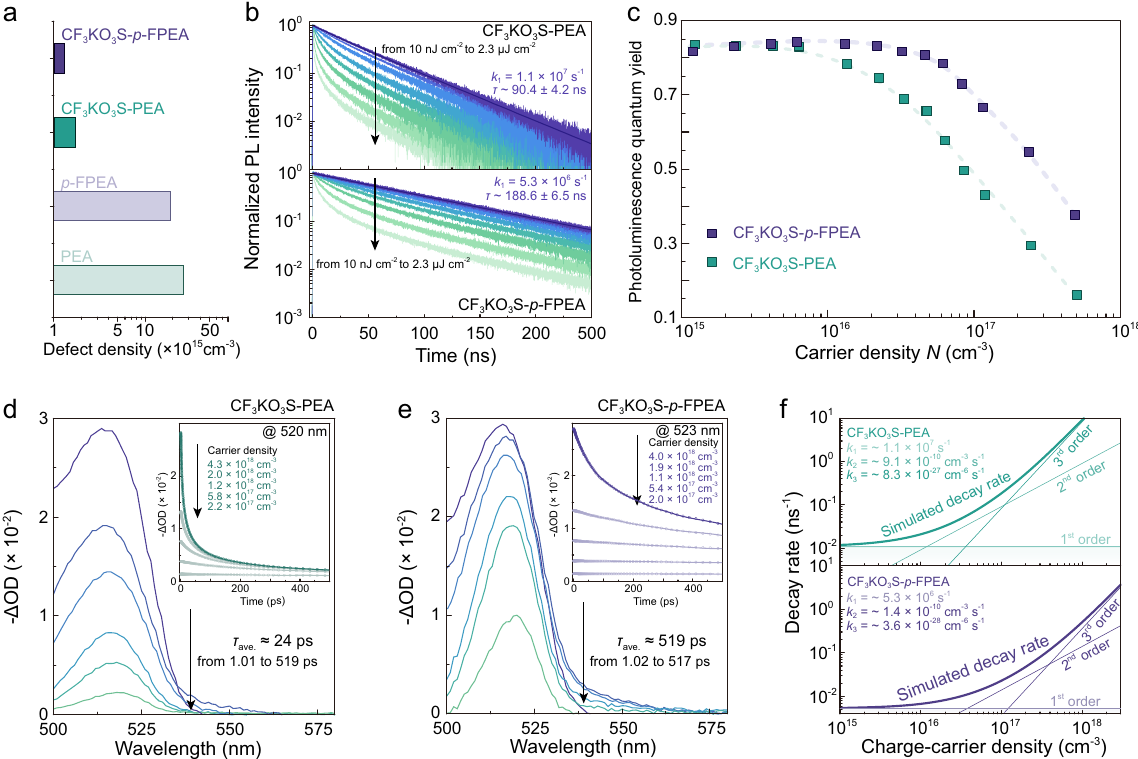
Fig. 3 Recombination dynamics for CF 3 KO 3 S treated quasi-2D fi lms. a Extracted defects density for different perovskite fi lms according to SCLC measurements. b TRPL spectra for CF 3 KO 3 S-PEA and CF 3 KO 3 S- p -FPEA fi lms under different excitation. c Film ’ s PLQYs as a function of carrier density for CF 3 KO 3 S-PEA and CF 3 KO 3 S- p -FPEA quasi-2D fi lms, respectively. TA spectra at different delay time under carrier density of ~4 × 10 18 cm − 3 for d CF 3 KO 3 S- PEA and e CF 3 KO 3 S- p -FPEA fi lms; the insets are the bleaching kinetics with different fl uences. f Simulated carrier decay rates as a function of